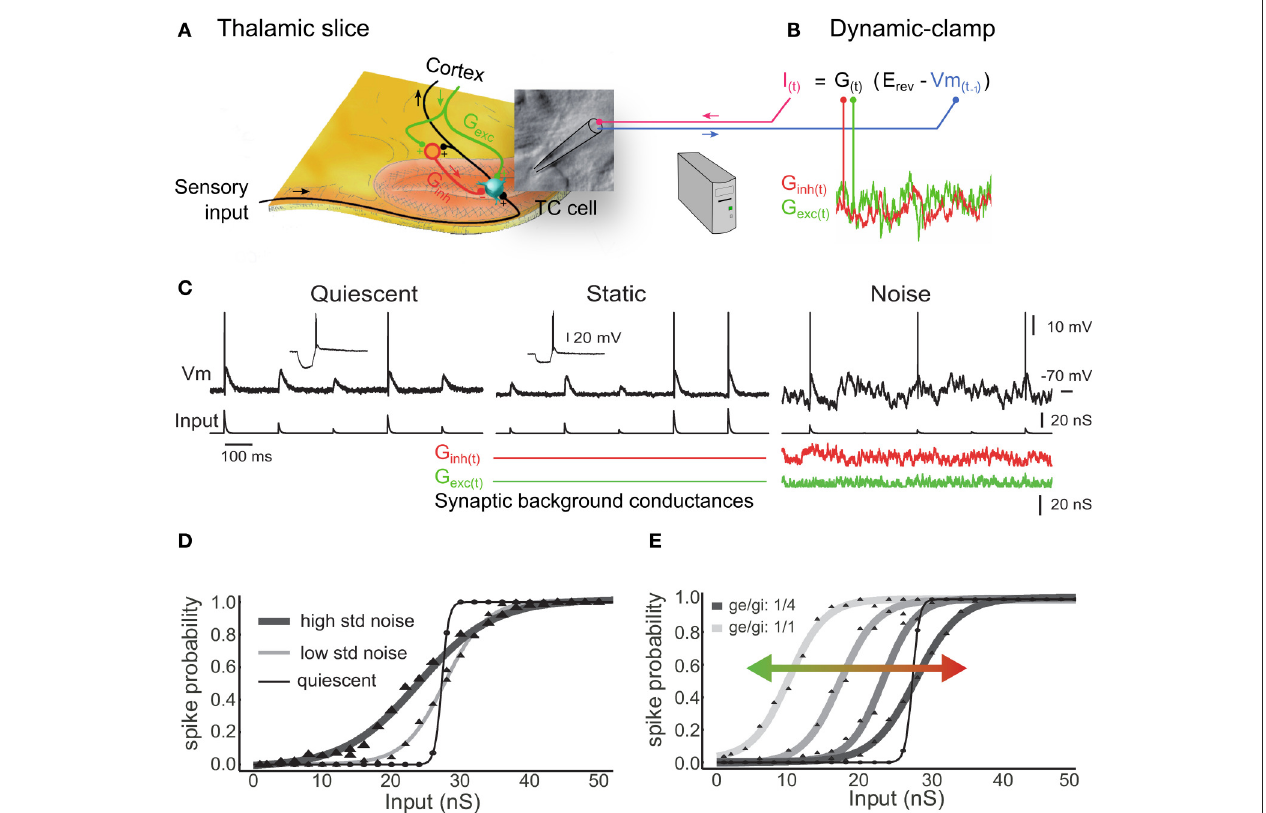
FIGURE 1 | Synaptic noise tunes the transfer function of thalamocortical cells recorded in vitro . (A) Illustration of a thalamic slice where a TC cell is recorded using a patch pipette. (B) The dynamic-clamp technique is used to stimulate TC cells with artificial sensory inputs and synaptic conductances, thus mimicking the impact of the corticothalamic feedback during sensory integration. (C) Voltage during injection of discrete retinal-like input conductance (quiescent) and with additional inhibitory plus excitatory background conductance that were either non-fluctuating (static) or stochastically fluctuating (noise). Combined inhibitory and excitatory conductances reduced the input resistance to ∼ 50% (insets in quiescent and static). (D) Probabilities of input conductance strengths to evoke at least one spike within a 20ms delay, fitted to sigmoid functions. In the noise condition (but not static; not shown, see in Wolfart et al., 2005), a multiplicative gain is induced, corresponding to a slope change of the response curve, and characterized by an increased sensitivity to small inputs and a decreased sensitivity to large inputs. Decreasing the variance of noise conductance values from high voltage variance noise (high std noise; 3.65mV; n = 24 ) to low noise (low std noise; 2.6mV; n = 5 ) changes the input-output slope and the sensitivity to small inputs. (E) Changing the ratio of excitatory/inhibitory conductances (1/1, 1/2, 1/3, and 1/4) induces an additive gain that shifts the dynamic input sensitivity range of the transfer function toward smaller inputs (leftward green shift) for higher ratios and toward larger inputs for lower ratios (rightward red shift). Modified from Wolfart et al.